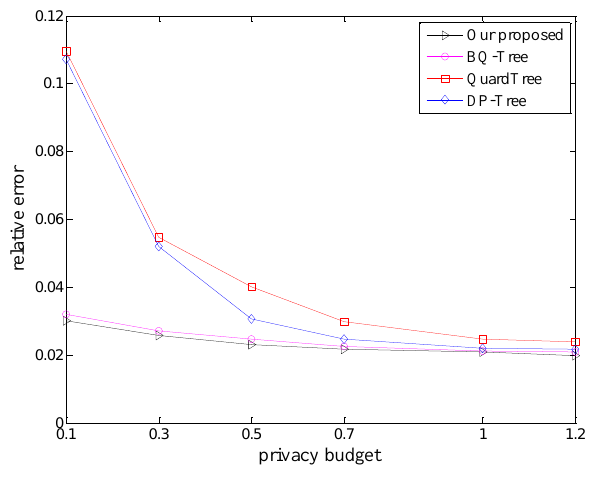
Figure 7. Query range Q = 10%.